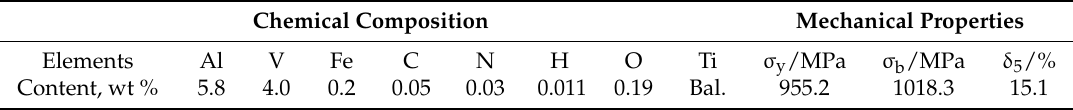
Figure 2. Schematic diagrams of the vertical welding positions investigated. Table 1. Chemical composition and mechanical properties of Ti6Al4V titanium alloy.